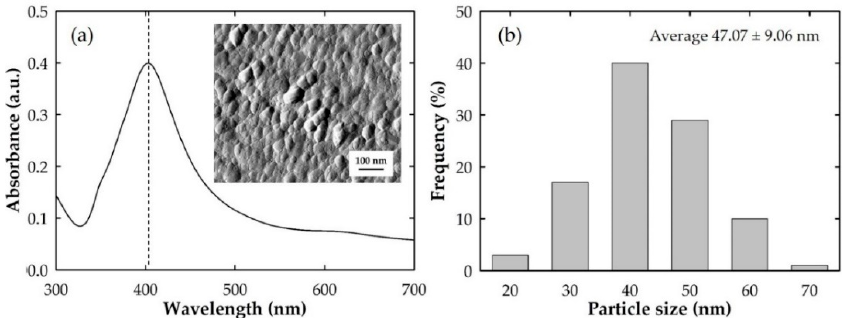
Figure 1. ( a ) UV–visible spectrum as measured by UV-Vis spectroscopy with an atomic force microscope